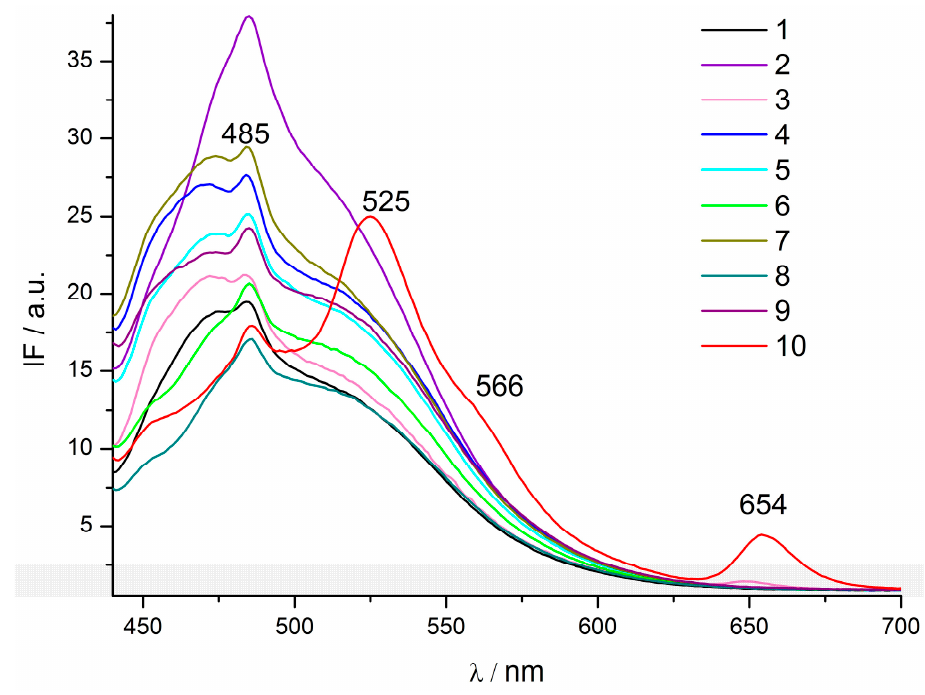
Figure 2. Fluorescence emission spectra of azulene-chalcone derivatives 1 – 10 .